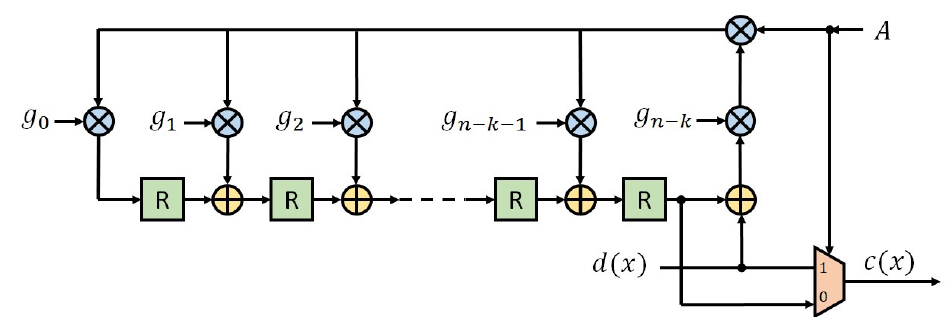
Figure 7. Systematic cyclic encoder LFSR circuit. d ( x ) is the data input and c ( x ) is the coded word. Writing on a page of the NAND flash chip was performed in portrait orientation as shown in Figure 8. The reason it is available this way is because it takes advantage of the logical operations of the LFSR. In the next section, writing on the NAND flash memory chip is described.